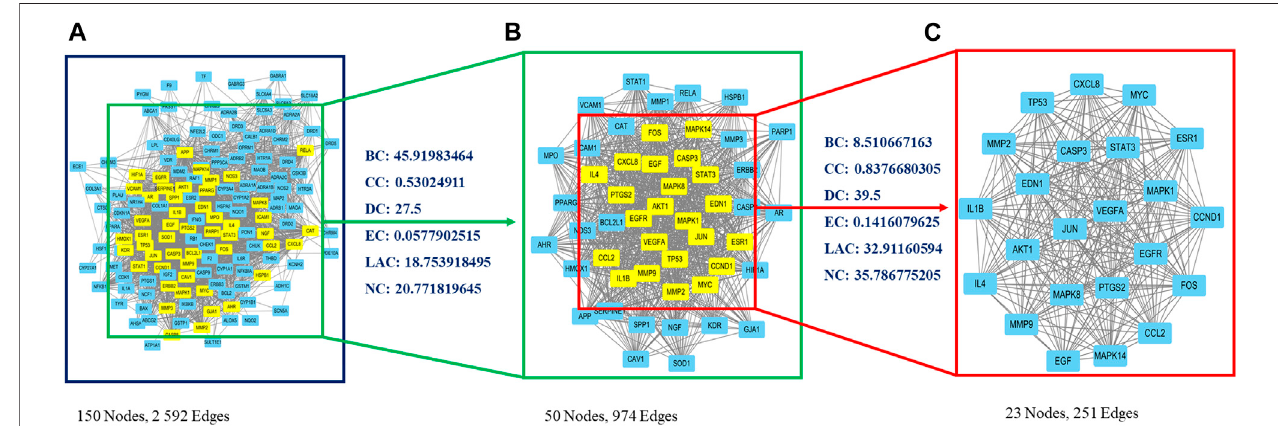
FIGURE 2 | Identi fi cation of core candidate targets of CDG against PD. (A) The interactive PPI network of CDG putative targets and PD-related targets. (B) PPI networkofsigni fi cantproteins extracted from (A) . (C) CorePPInetworkofcandidateCDG targets forPDtreatment extractedfrom (B) .BC,betweennesscentrality;CC, closeness centrality; DC, degree centrality; EC, eigenvector centrality; LAC, local average connectivity-based method; NC, network